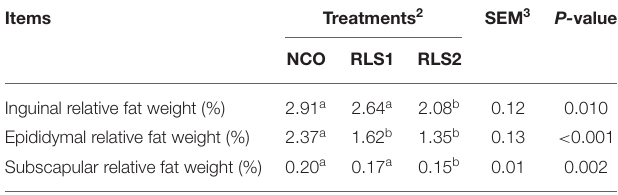
TABLE 2 | Effects of RLS on relative fat weight in rats 1